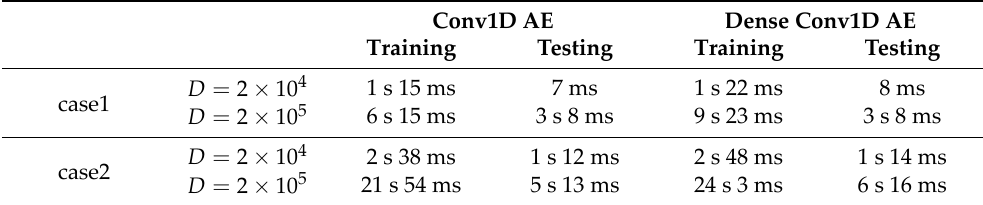
Table 4. The network construction in this paper is implemented based on Nvidia Tesla T4 and the Keras platform. The simulation results show that the cost of the proposed method is mainly concentrated in the model training phase, and the system complexity increases with deeper network structures and increasing data sizes. In the testing phase, Dense Conv1D AE and Conv1D AE share similar run times per step for signal detection. Table 4. Complexity comparison between case1 and case2. Conv1D AE Dense Conv1D